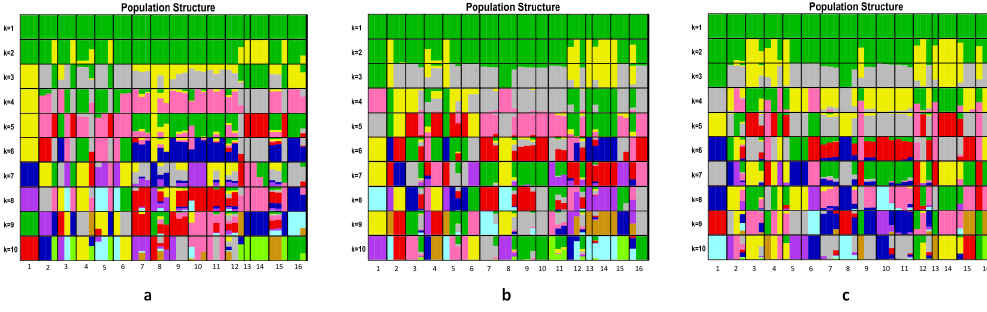
Figure 4. Genetic structure 16 populations of C. dactylon along latitudinal gradient at di ff erent temperatures. The STRUCTURE ancestry kinship (K) is shown from 1 to 10. Various colors indicate di ff erent genetic clusters. ( a ) structure of C. dactylon at 5 ◦ C. ( b ) structure of C. dactylon at 20 ◦ C. ( c ) structure of C. dactylon at 35 ◦